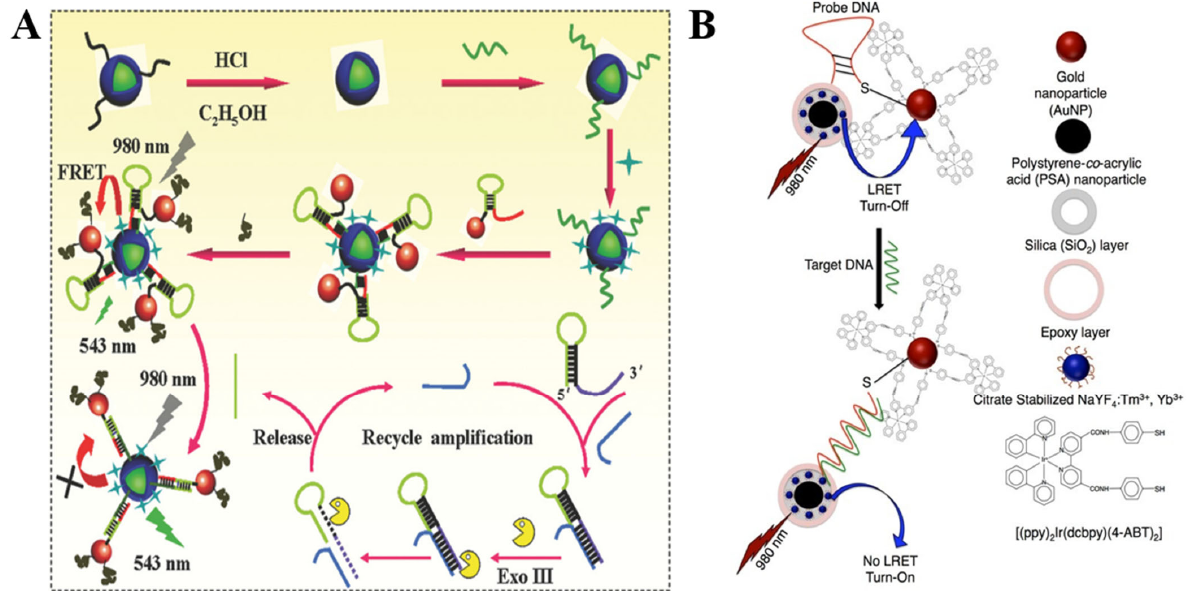
Figure 4. ( A ) Schematics of the UCNPs–AuNPs plasmon ‐ modulated biosensing platform for highly sensitive detection of tumor ‐ related ncRNA via the Exo III ‐ assisted cycling amplification strategy. Reprinted with permission from reference [75]. ( B ) Schematics of the composition and energy trans ‐ fer mechanism of ssDNA optical sensor composed of PSA/SiO 2 coated UCNP and cyclometalated Ir(III) ‐ AuNPs. Reprinted with permission from reference